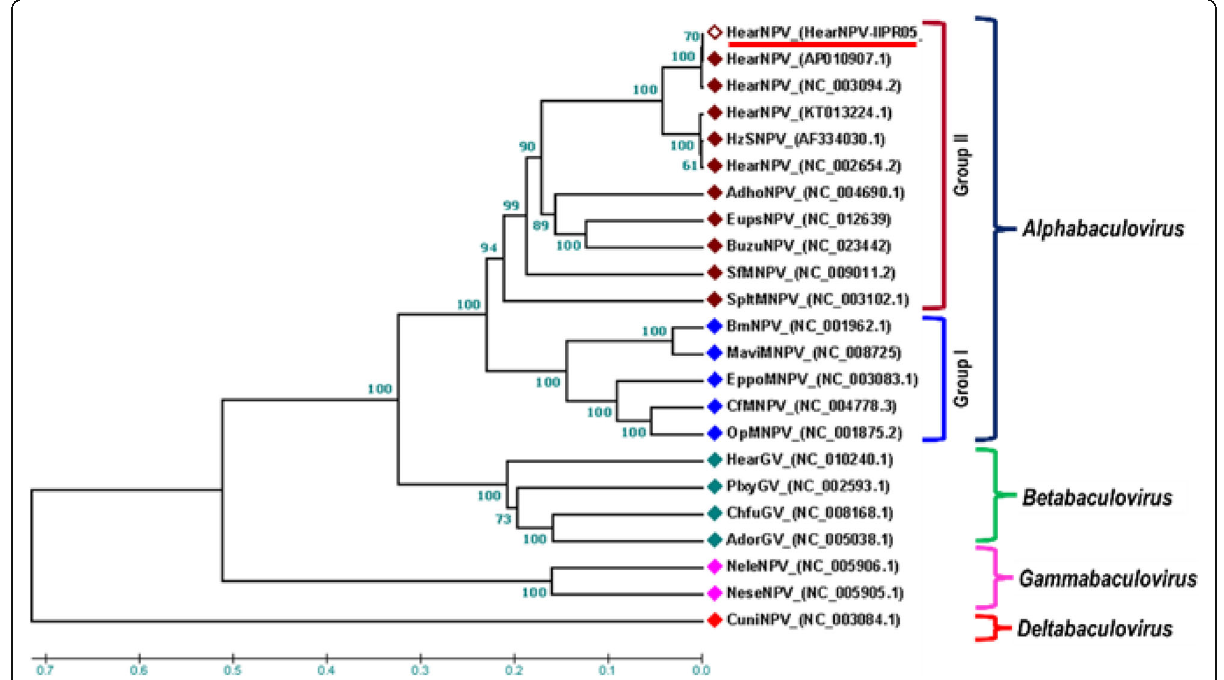
Fig. 6 Phylogeny of concatenated amino acid sequences of polh , pif-1 , and lef-8